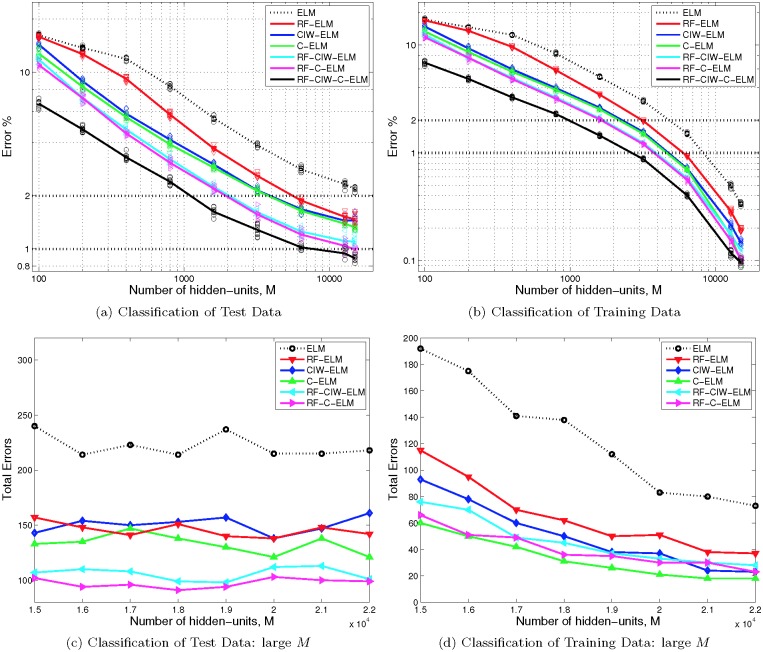
Error rates for MNIST images for various SLFN ELM methods with shaped input weights.The first row shows the mean error percentage from 10 different trained networks applied to classify (a) the 10000-point MNIST test data set, and (b) the 60000-point MNIST training data set used to train the networks, for various different sizes of hidden layer, M. Markers show the actual error percentage from each of the 10 networks. Note that the data for the combination RF-CIW-C-ELM method is plotted against M used in just one of the three parts of the overall network; the total number of hidden units used is actually 2M+500. Therefore RF-CIW-C-ELM does not outperform the other methods for the same total number of hidden-units for small M. However it can be seen that for large M RF-CIW-C-ELM produces results below 1% error on the test data set and provide the best error rates overall. The second row illustrates that increasing the number of hidden-units above about M = 15000 leads to overfitting, since as shown in (c), the total number of errors plateaus, whilst the total number of errors on the training set continues to decrease (shown in (d)). Note that (c) and (d) show results from a single trained network only.